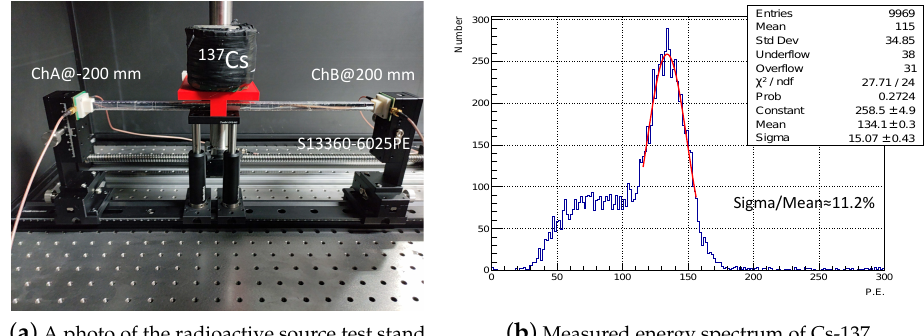
Figure 10. Radioactive source test of a 40 cm long BGO crystal bar.